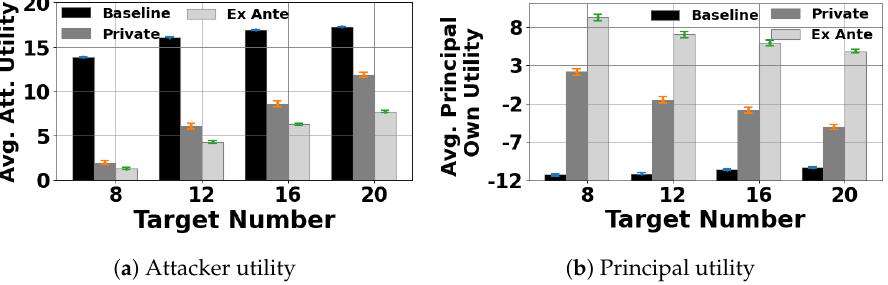
Figure 4. The principal optimizes her own utility when | D | = | Λ | = 4 and the defenders’ cost range C d ( t ) ∈ [ 0,10 ] .